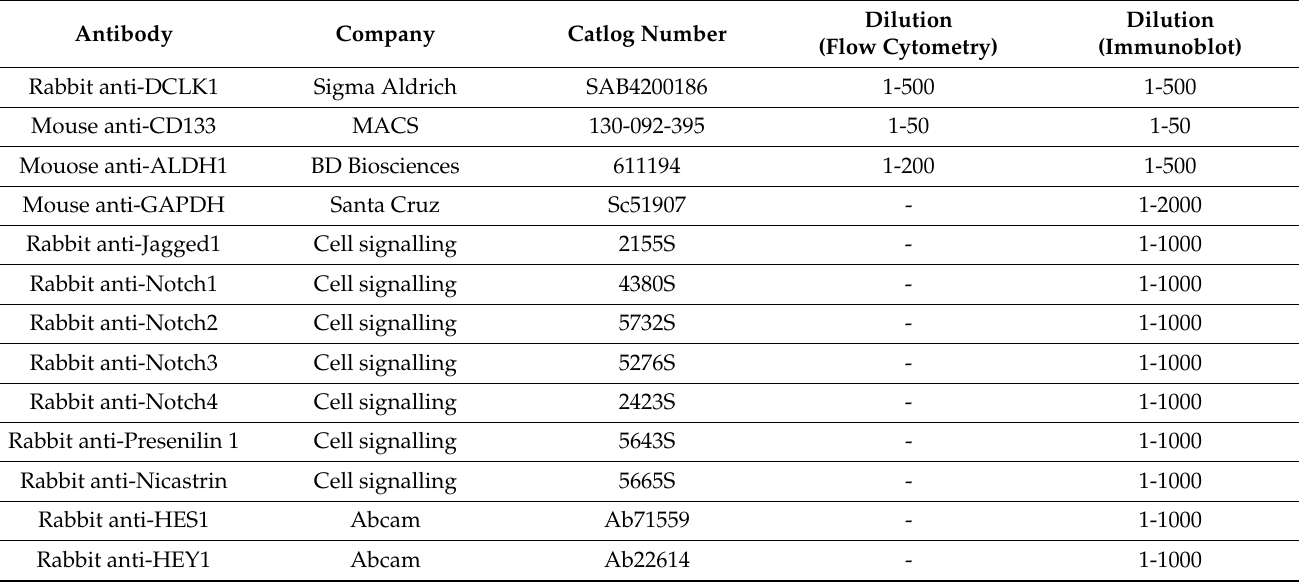
Table 1. List of antibodies and dilution factor used for flow cytometry and western blot.